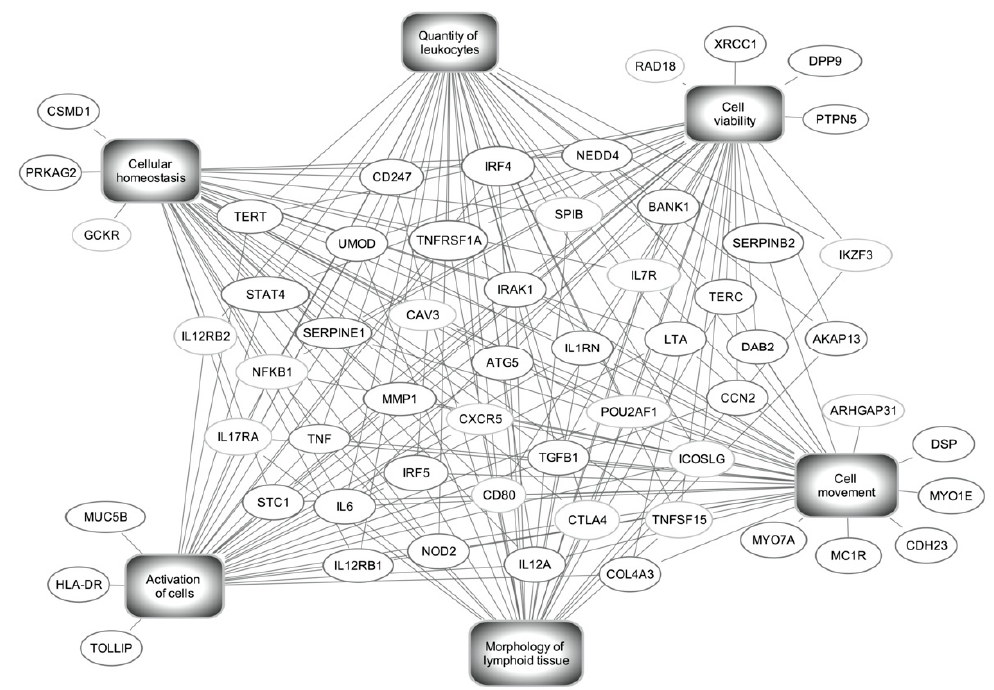
Figure 1. GWAS of fibrosing disorders. Pooled network of genes from genome-wide